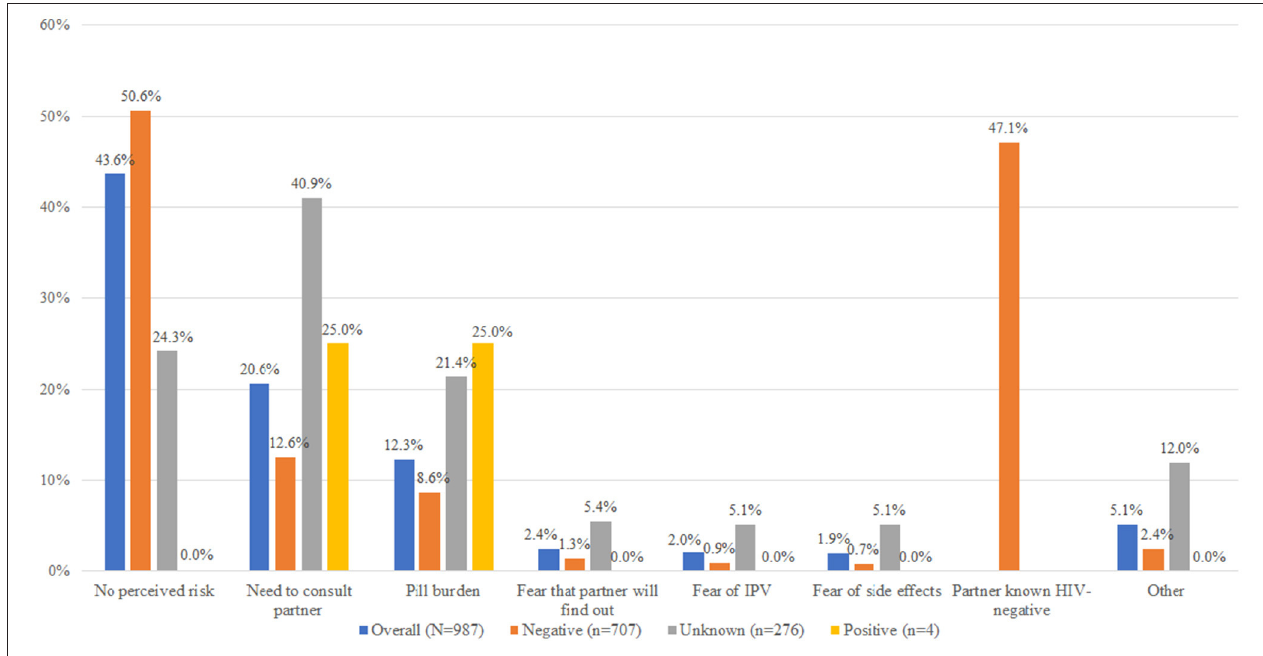
FIGURE 2 | Reasons for declining PrEP by reported male partner HIV